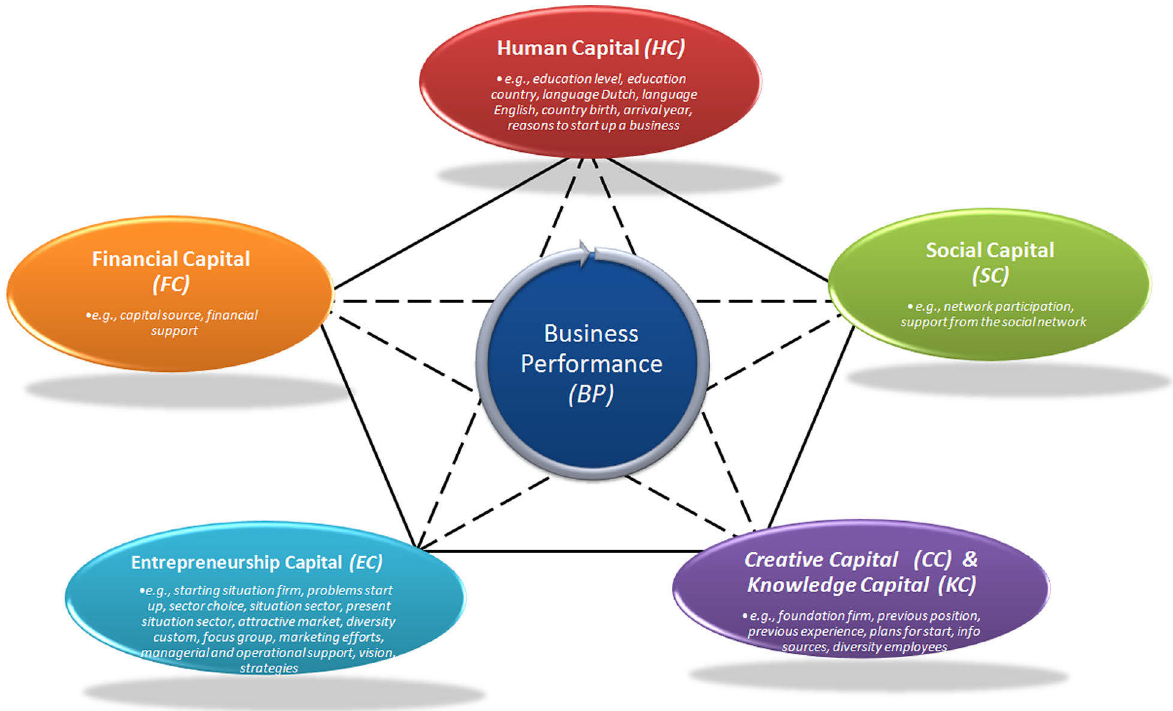
Fig. 1. Model of the complex field of force of business